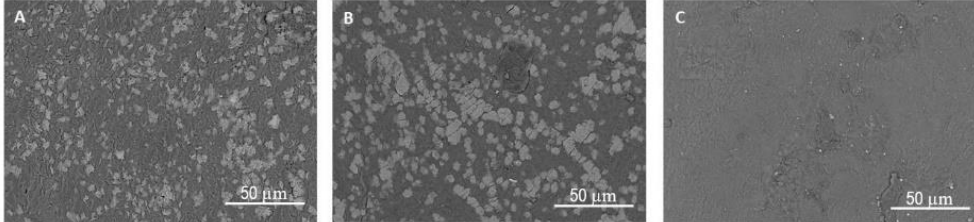
Figure 5. SEM micrographs of the surface of the dried hydrogels with the CA cross-linking agent at the concentrations of A) 5% w/w; B) 10% w/w and C) 15% w/w.